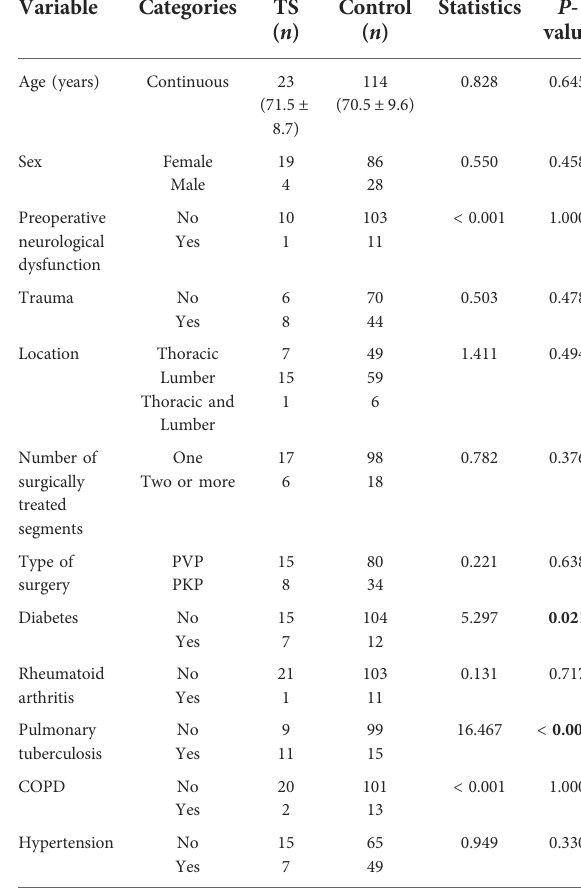
TABLE 4 Comparison of clinical features between TS and Control group.